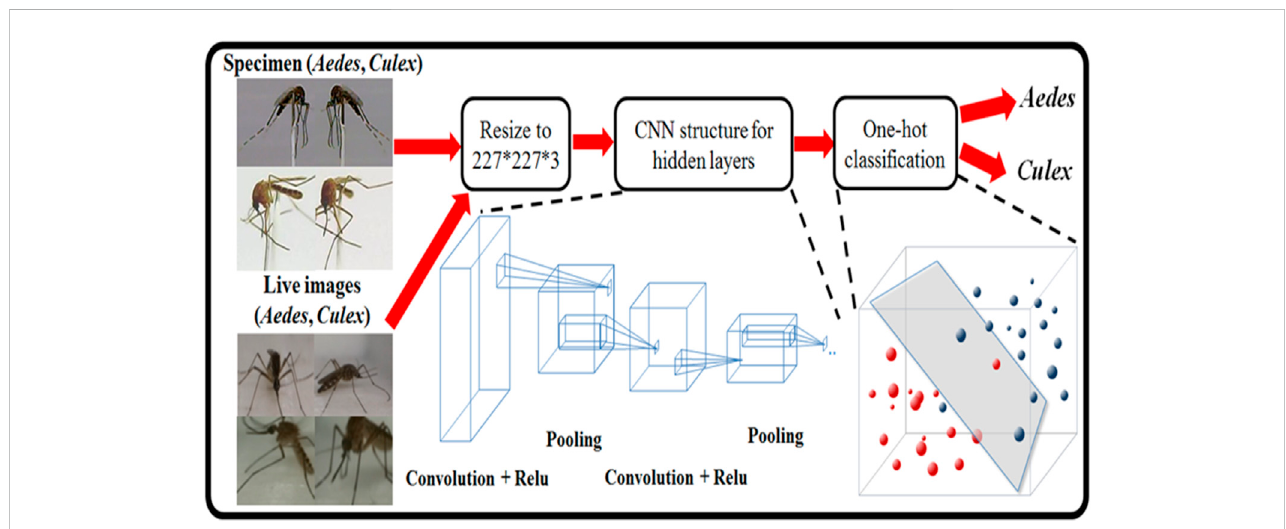
FIGURE 3 TheCNNwastrainedoncapturedmosquitoimagesandfeaturepointsthroughconvolution.However,withincreasingpixelsizeoftheimage,numberof featurepixels,andnumberoffeaturesfound,thecomputationalcostdramaticallyincreases.Therefore,thepoolingmethodwasusedtocompresstheimages while retaining essential image features to increase performance. Finally, one hot encoding classi fi cation was performed to differentiate Ae. aegypti and Cx. quinquefasciatus